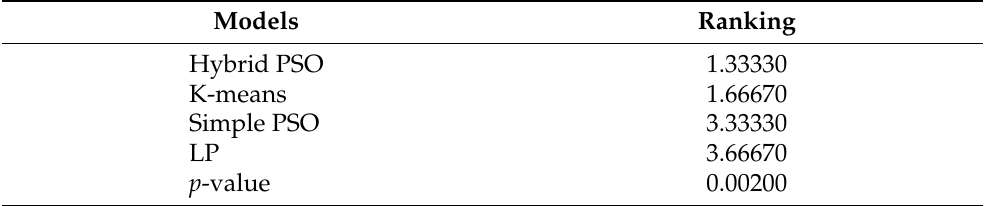
Table 21. The results from the Friedman test: the ranking applied to the arithmetic mean values of the silhouette coefficients.